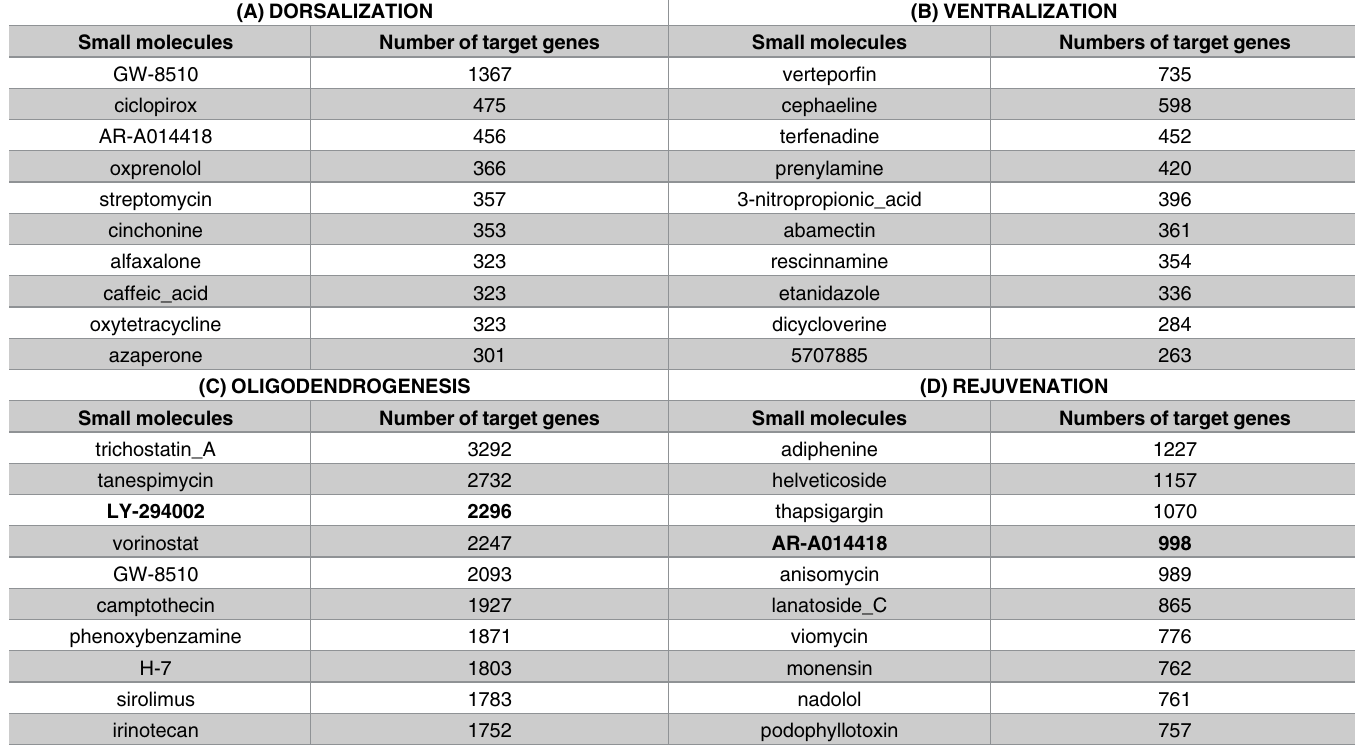
Table 1. Top-ranked small molecules identified from SPIED/CMAP analysis of small molecules that promote (A) dorsalization of the SVZ, (B) ven- tralization of the SVZ, (C) oligodendrogenesis, and (D) neurogenesis. Small moleculesare ranked accordingto the largest numbers of “target” or “per- turbed” genes. For the full list, pleaserefer to